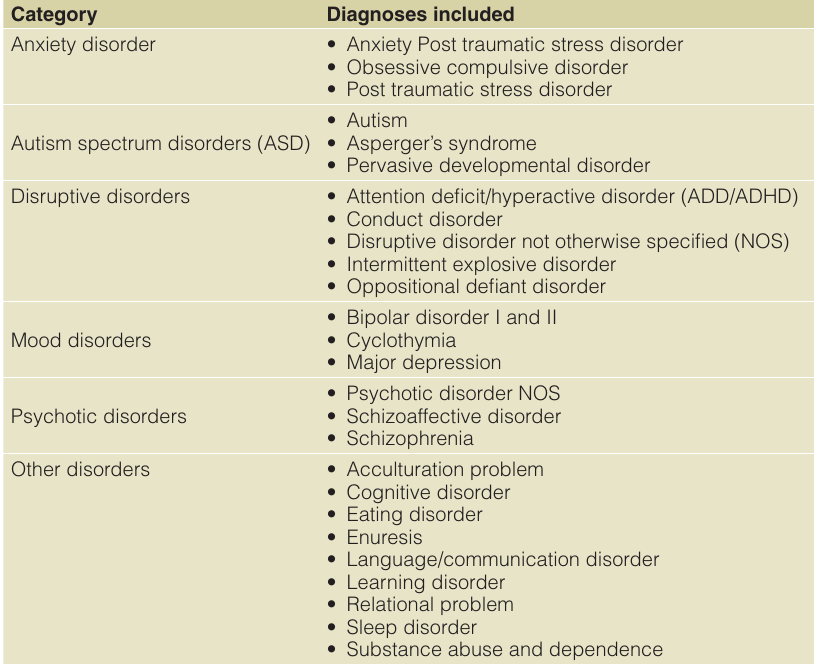
Table 1. Diagnostic categories. Category Diagnoses